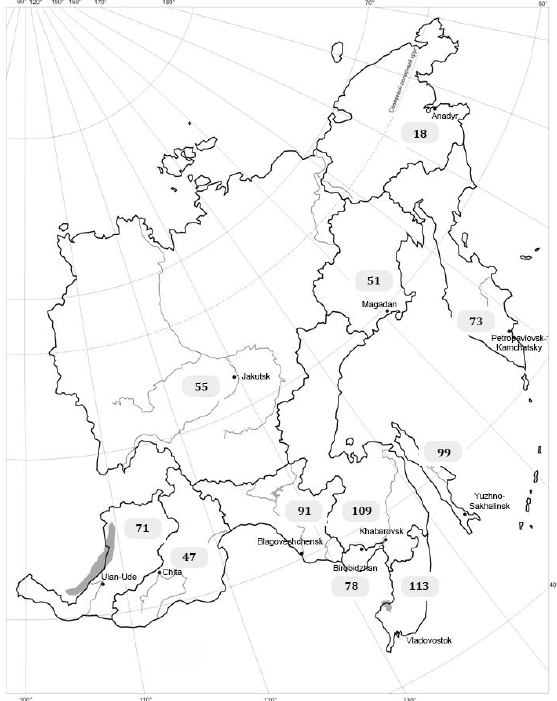
Figure 1. The number of invasive plant species in administrative subjects of The Far Eastern Federal District (taking into consideration currently available data (see Table 1) and original materials).